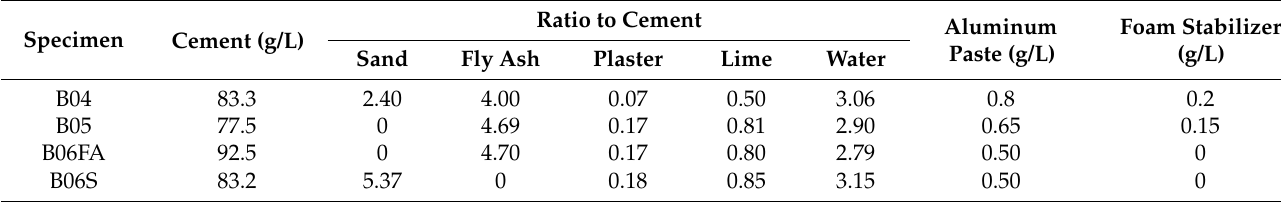
Table 3. Mixing proportion of raw materials of